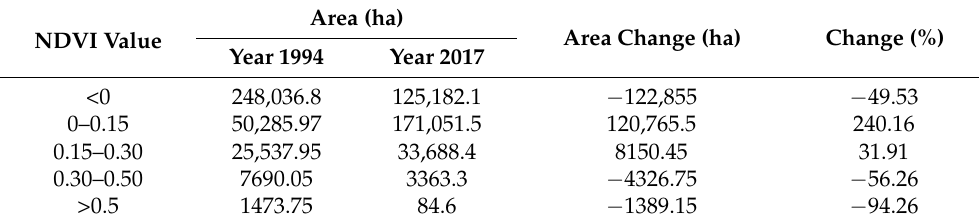
Table 1. The NDVI value change matrix from 1994 to 2017 in the study area. Area NDVI Value